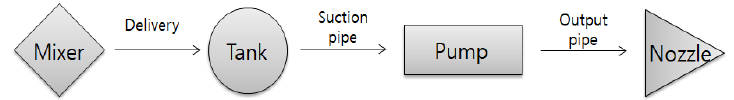
Figure 2. Sequence of the three-dimensional additive construction (3DAC) system [12].